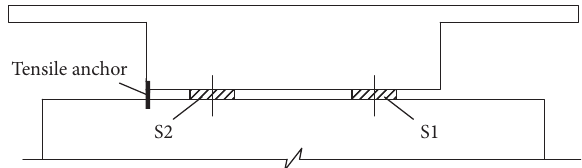
Figure 16: Tensile anchor installed at the end bearing sections.